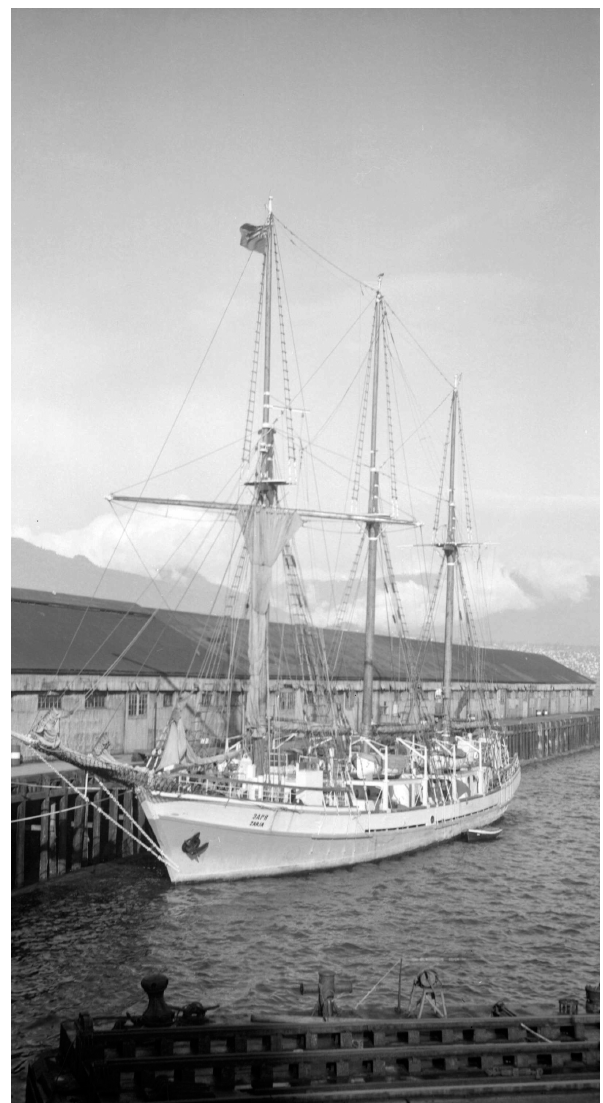
Figure 11. Non-magnetic oceanographic research vessel (schooner) Zarya (or Zarja ). Built in Finland in 1952, equipped with Soviet geophysical instruments, including special magnetome- ters for geomagnetic observations during the IGY. Photo taken in Canada, circa 1962 (http://www.wrk.ru, last access: 2 June 2020).